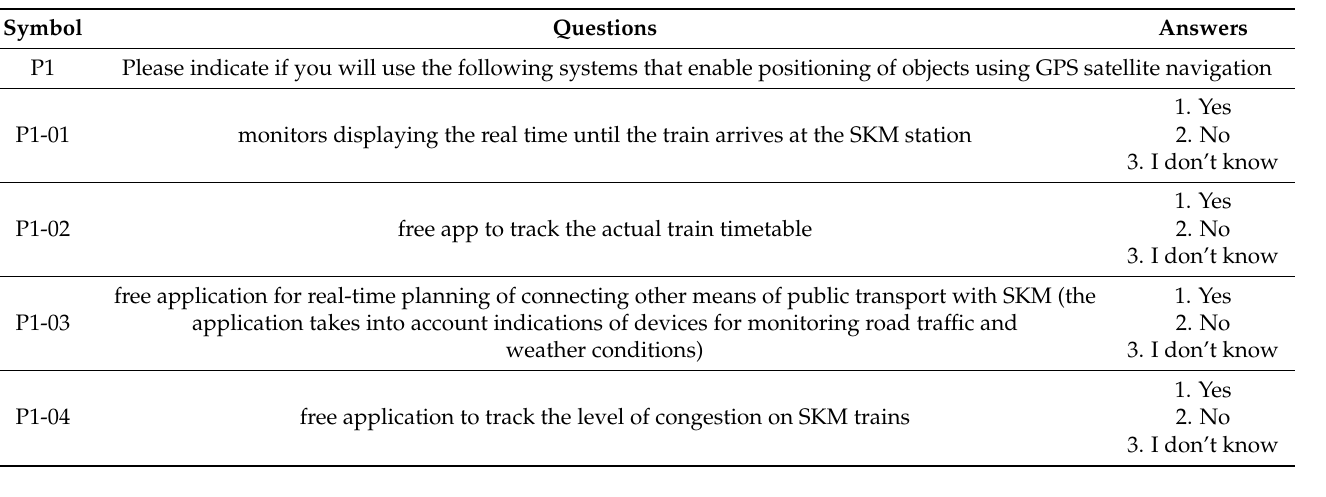
Table 1. Questions in the survey questionnaire.